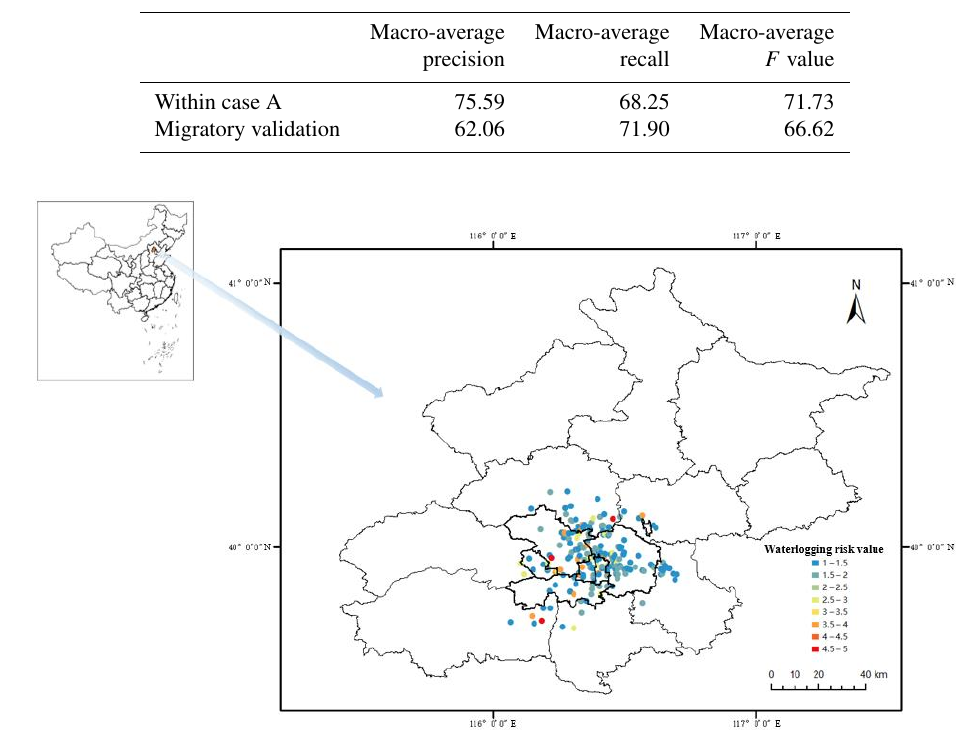
Figure 4. Annotation of the waterlogging microblogs with location information and risk value on the original map.